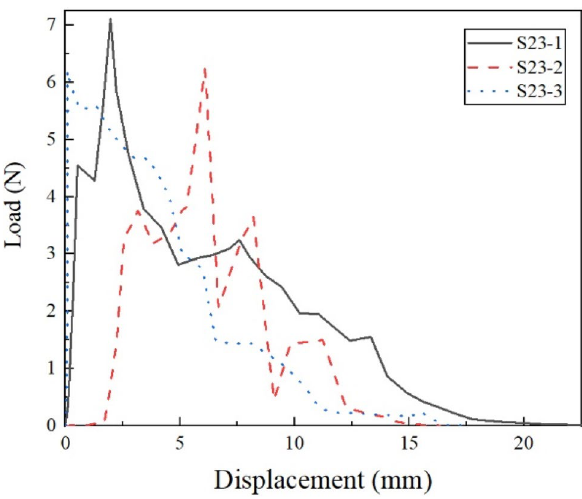
Figure 6. pullout load–displacement curves of the three parallel samples compacted at 20% water content and 1.55 g/cm 3 dry